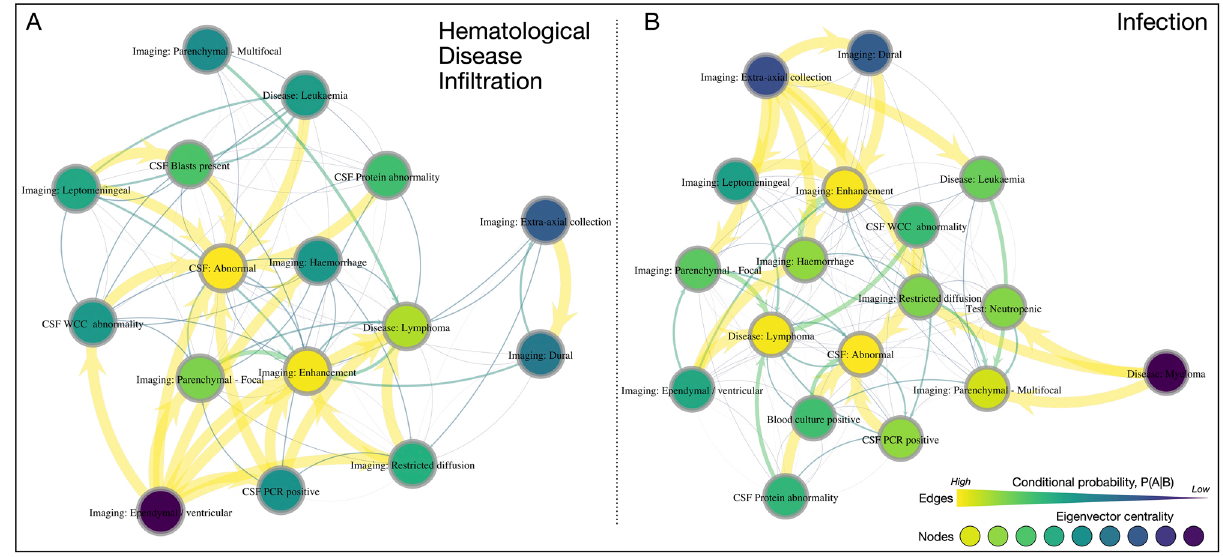
Figure 2. Visual network analysis of CNS hematological disease involvement and infection. ( A ) Graphical representation of CNS hematological disease feature network. ( B ) Graphical representation of CNS infection feature network. Nodes are color-coded according to their eigenvector centrality, and edge size and color is proportional to the directed conditional probability, with color key as shown. CSF cerebrospinal fluid, PCR polymerase chain reaction, WCC white cell